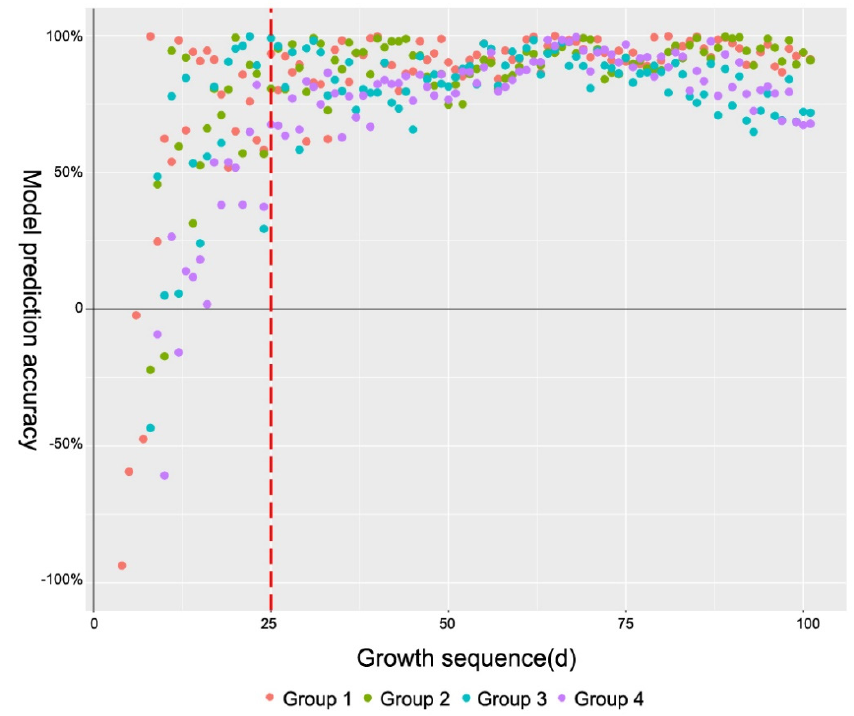
Figure 4. Scatter plot of inversion accuracy of the inversion models for the samples of four groups.